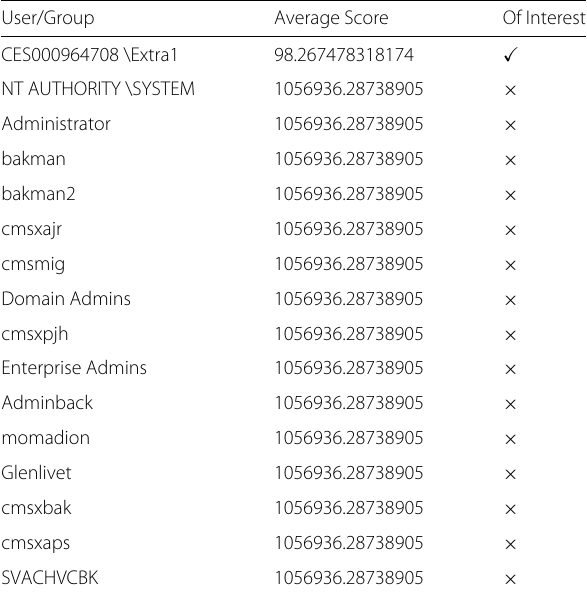
Table 2 Results from Creeper demonstrating user “Extra1” has been identified as a potential instance of permission